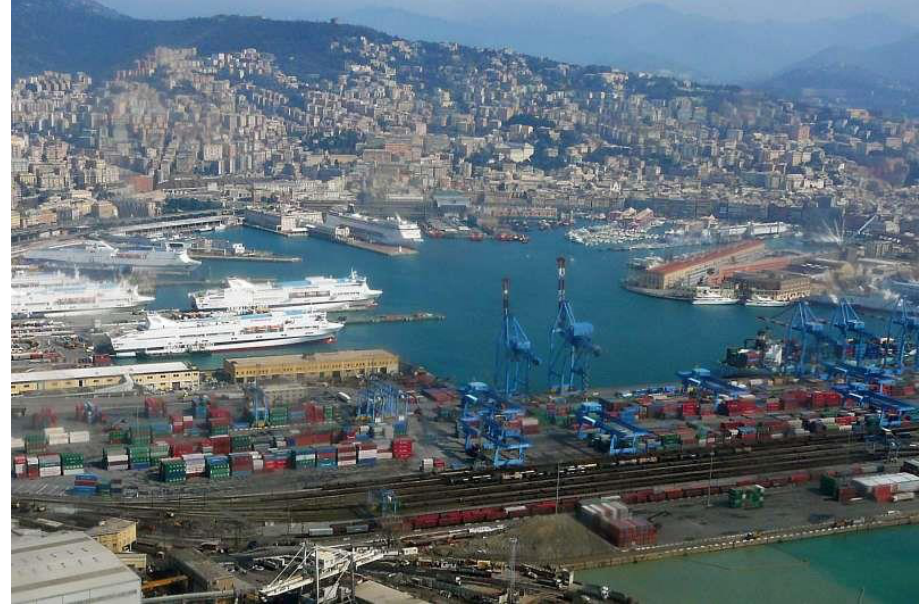
Figure 1. Aerial View of the Port of Genoa Table 5. Human populations in Italy’s Ports